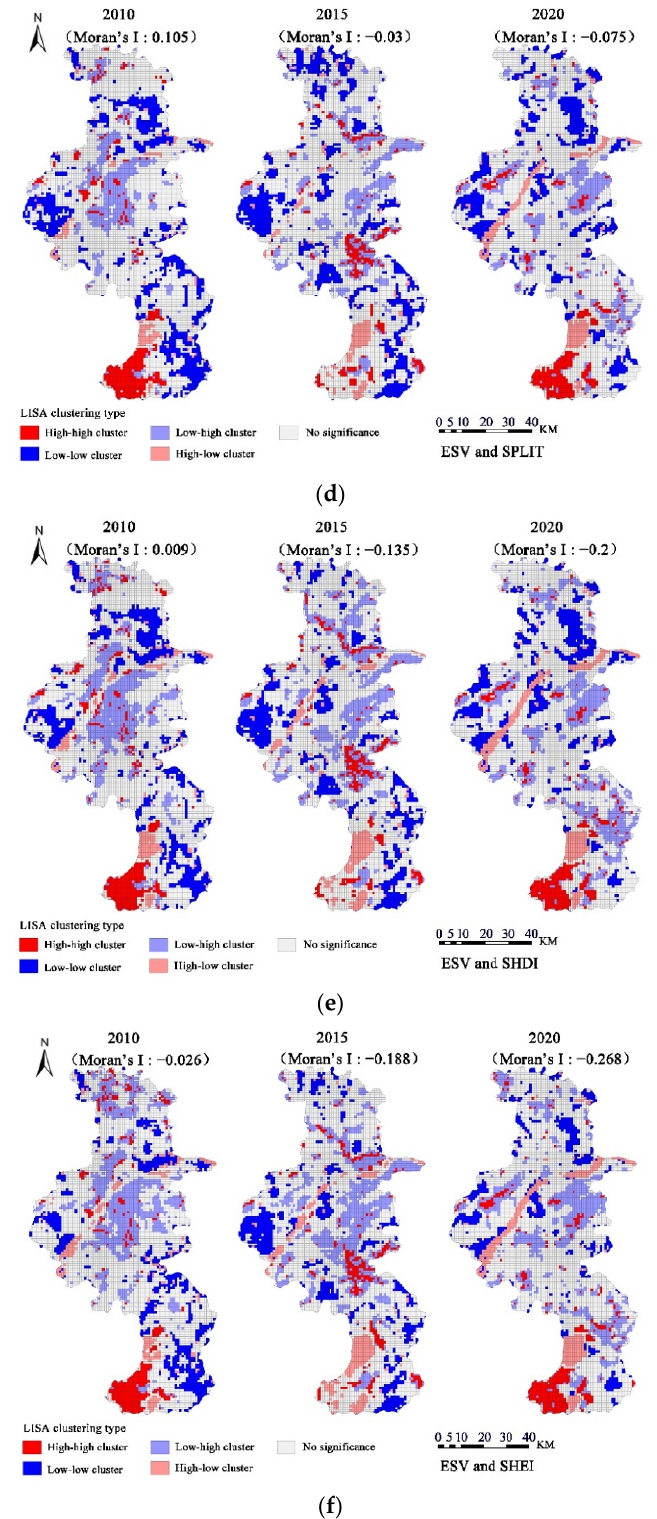
Figure 5. Bivariate spatial autocorrelation analysis of ESV and the landscape pattern index. ( a ) cluster distribution of ESV and PD; ( b ) cluster distribution of ESV and LPI; ( c ) cluster distribution of ESV and CONTAG; ( d ) cluster distribution of ESV and SPLIT; ( e ) cluster distribution of ESV and SHDI; ( f ) cluster distribution of ESV and SHEI.